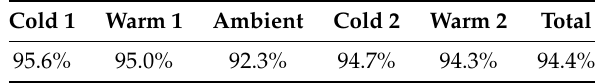
Figure 3. ( a ) Temperature with its 95% confidence intervals at the first time step. ( b ) Differences between the estimated temperature and the reference temperature at the first time step. Table 2. Percentage of reference temperature within estimated 95% confidence